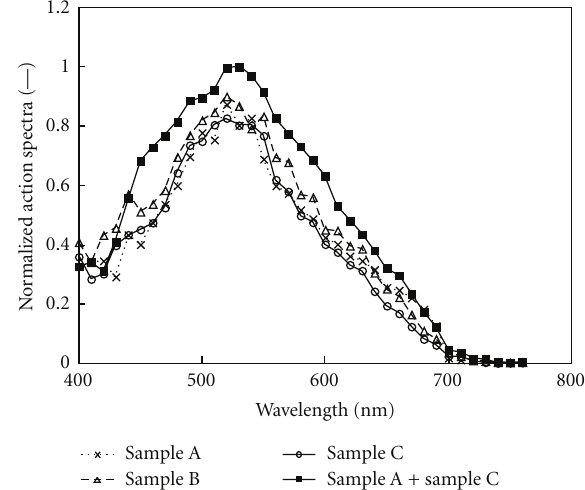
Figure 9: I - V characteristics of DSSCs with TiO 2 -coated layer made from samples A–C.